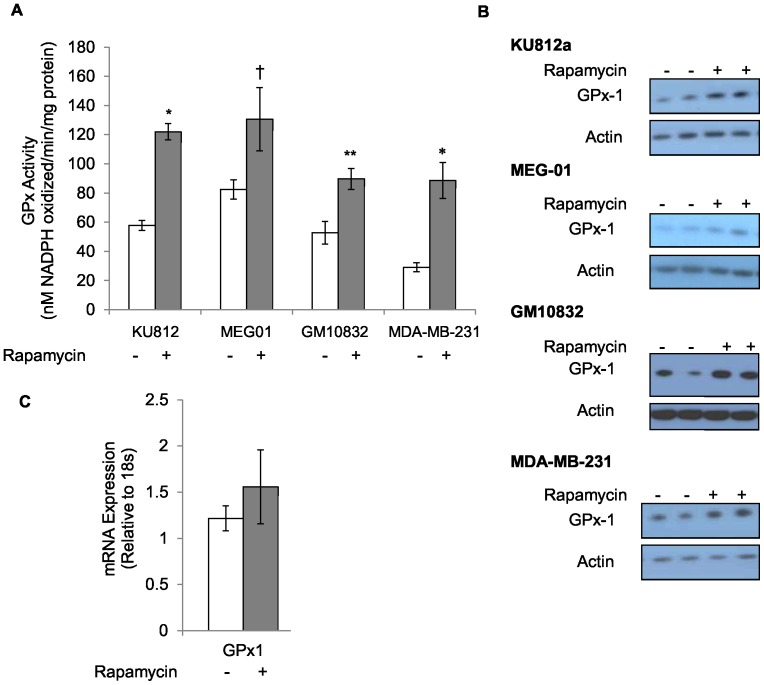
Rapamycin enhances GPx-1 protein and enzyme activity levels in all cell lines investigated.The effect of rapamycin on GPx-1 activity (A) and protein levels (B) in KU812a, MEG-01 GM10832 or MDA-MB-231 is shown. The effect of rapamycin on steady-state GPx-1 transcript levels as determined by RT-qPCR and normalization of GPx-1 Ct values to Ct values for 18s RNA (C). Rapamycin significantly increased protein respectively 3-fold and 1.3-fold in KU812a and MEG-01 (P = 0.05). Steady state transcript levels for GPx-1 were unaffected by treatment with rapamycin in KU812a. Data shown is representative of three independent experiments. * = P<0.001, ** = P<0.01. † = P<0.05. Error bars indicate S.D.